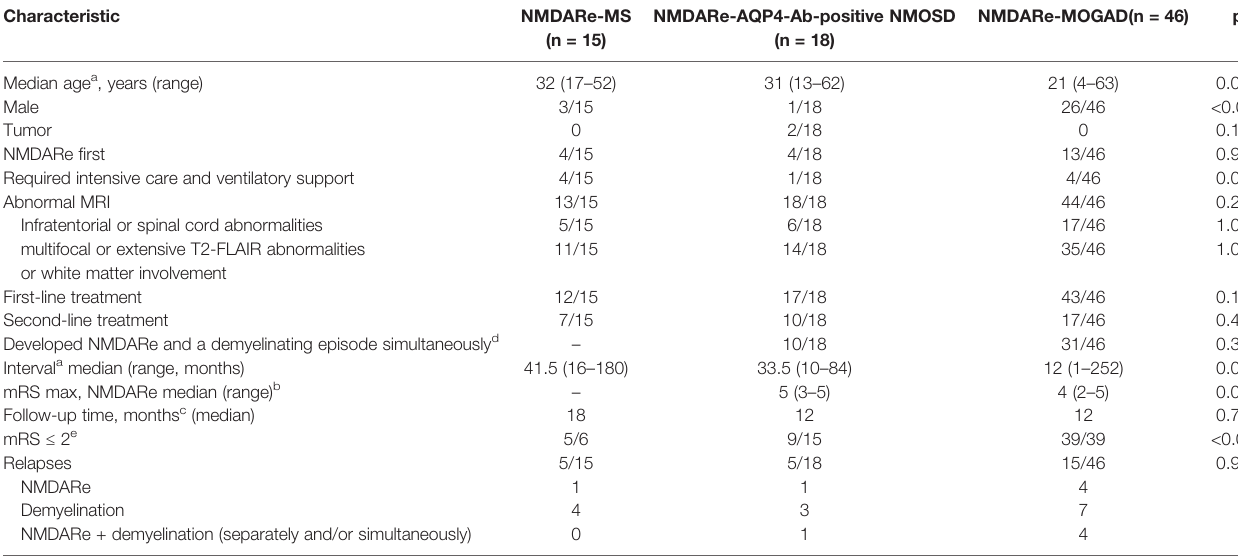
TABLE 1 | Demographics, clinical characteristics, laboratory data, and treatments in the fi rst NMDARe episode of three groups.